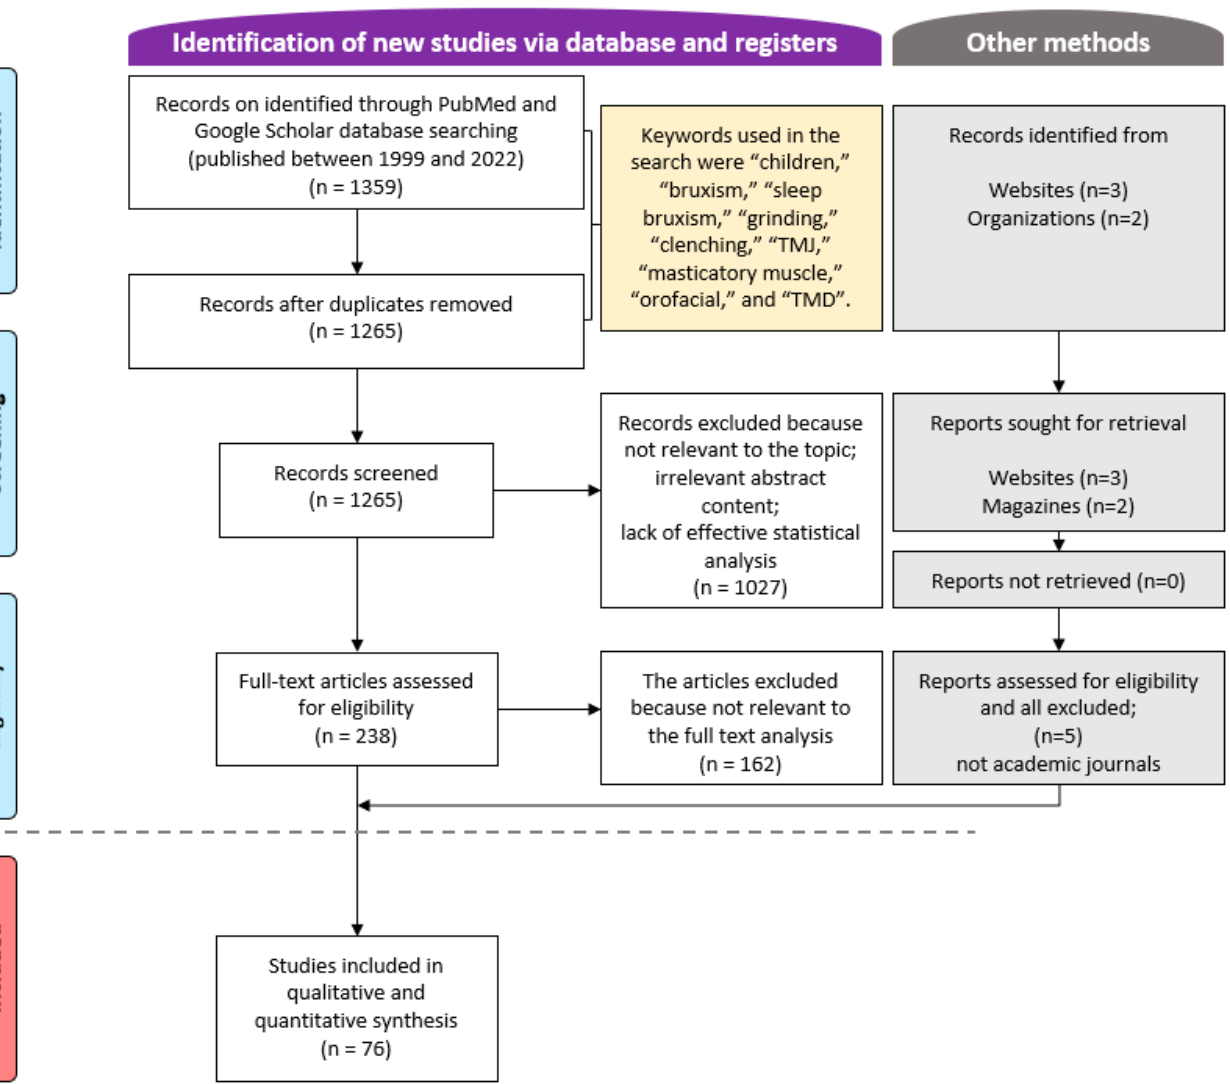
Figure 1. Flow chart of the article selection process.